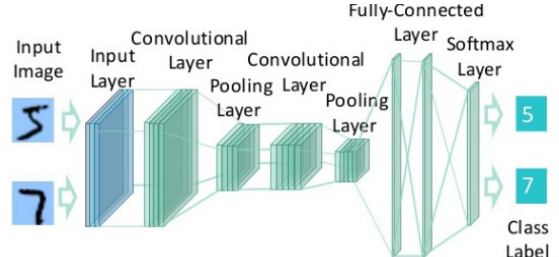
Figure 3. Industrial Setup for fast